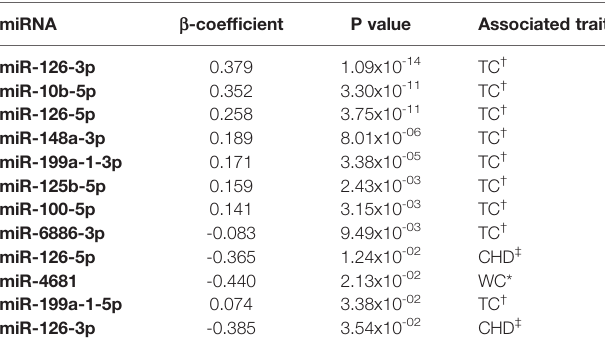
Model 1: adjusted for: age, gender, current smoking. *Model 1 +